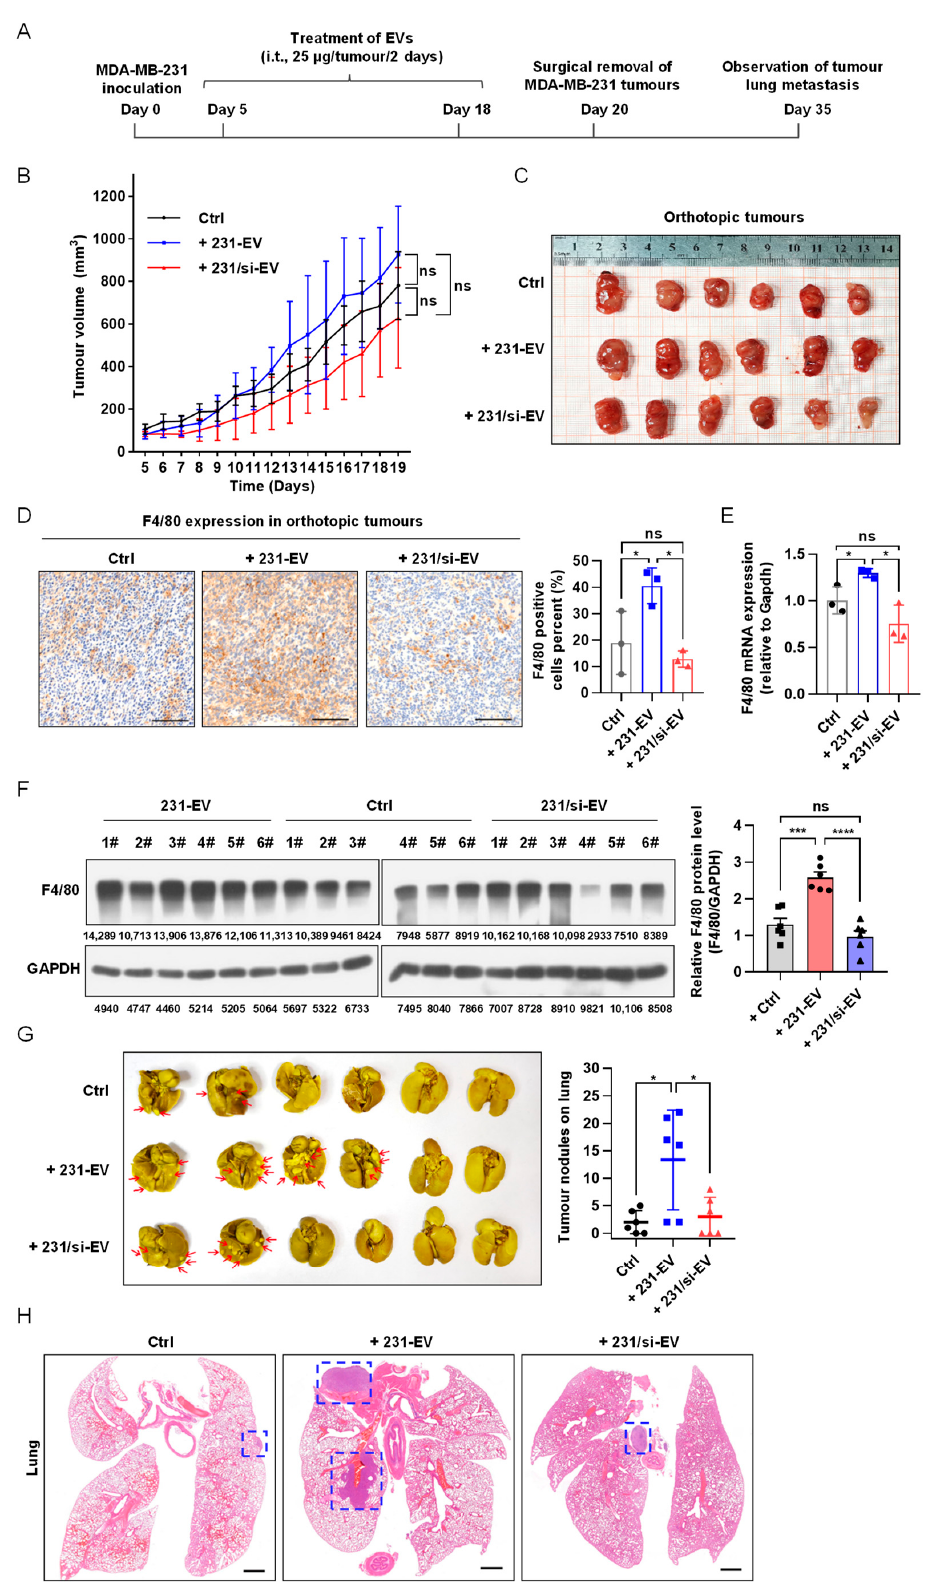
Figure 3. EVs derived from breast cancer cells expressing a high level of SIPA1 increase the infiltration of macrophages into tumour tissues and promote tumour metastasis. ( A ) Schematic diagram of the schedule for an MDA-MB-231 orthotopic nude mouse model (i.t, intratumoural injection). ( B )